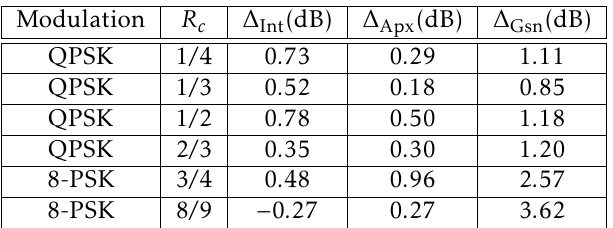
Table 2. Performance bound in dB for the outage probability P using numerical integration, approximation, and Gaussian input distribution assumption at BLER = 10 − 4